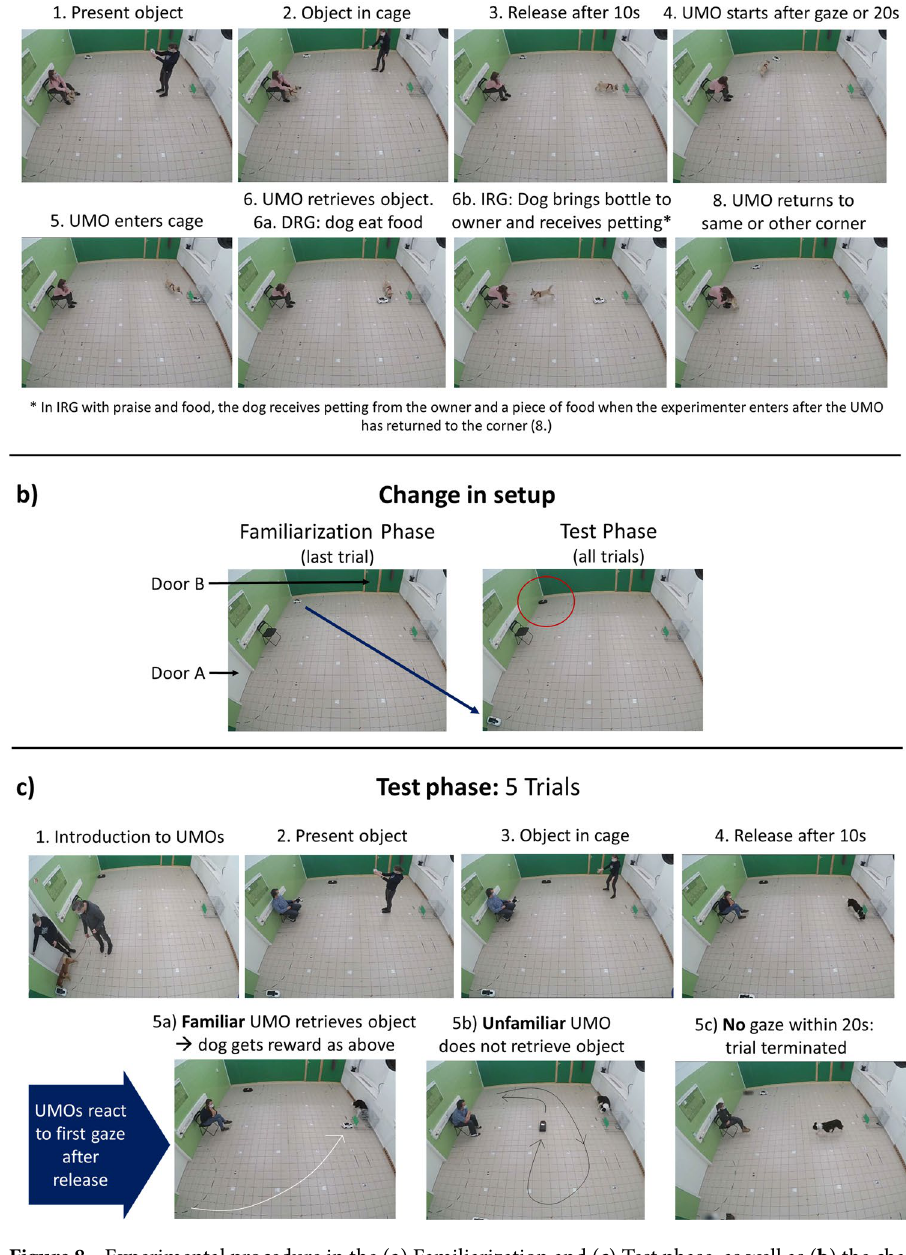
Test partners. As UMOs, we used two remote-controlled cars with magnets on their fronts that dif- fered in embodiment and sound. All dogs met one white (36 cm × 18 cm × 13.5 cm) and one black UMO (42 cm × 18 cm × 9.5 or 8.5 cm) (for detailed information see Supplementary Methods) and we counterbalanced between dogs whether the familiar or unfamiliar UMO was black or white. The familiar UMO was introduced to dogs during the Pretest and the Familiarization phases, and retrieved the object from the cage in both the Famil- iarization and the following Test phase. The second UMO was only introduced in the Test phase (unfamiliar